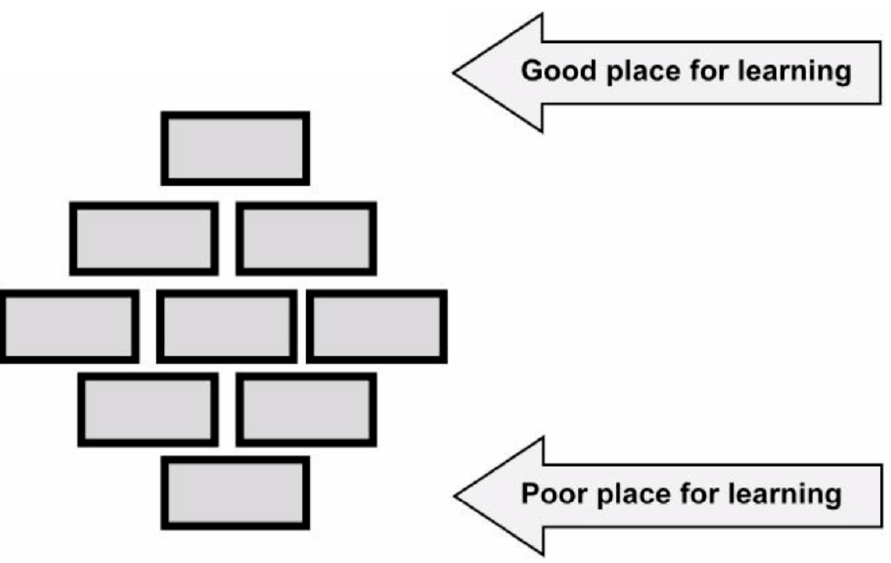
Figure 1. Instructions for ‘Diamond Ranking’ nine images according to opinions about suitability for learning.